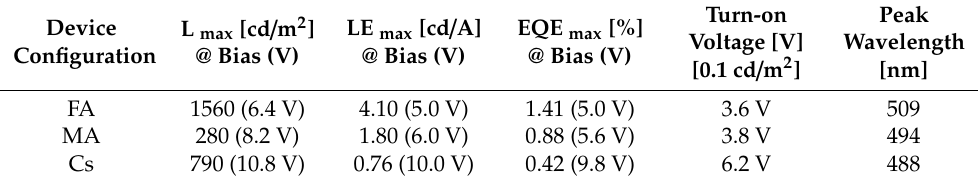
Figure 3. ( a ) Current density–voltage curves, ( b ) luminance–voltage curves, ( c ) EQE–voltage curves and ( d ) luminance efficiency–voltage curves of FA, MA, and Cs-based quasi-2D PeLEDs. Table 1. Device performance of FA, MA, and Cs-based quasi-2D PeLEDs.